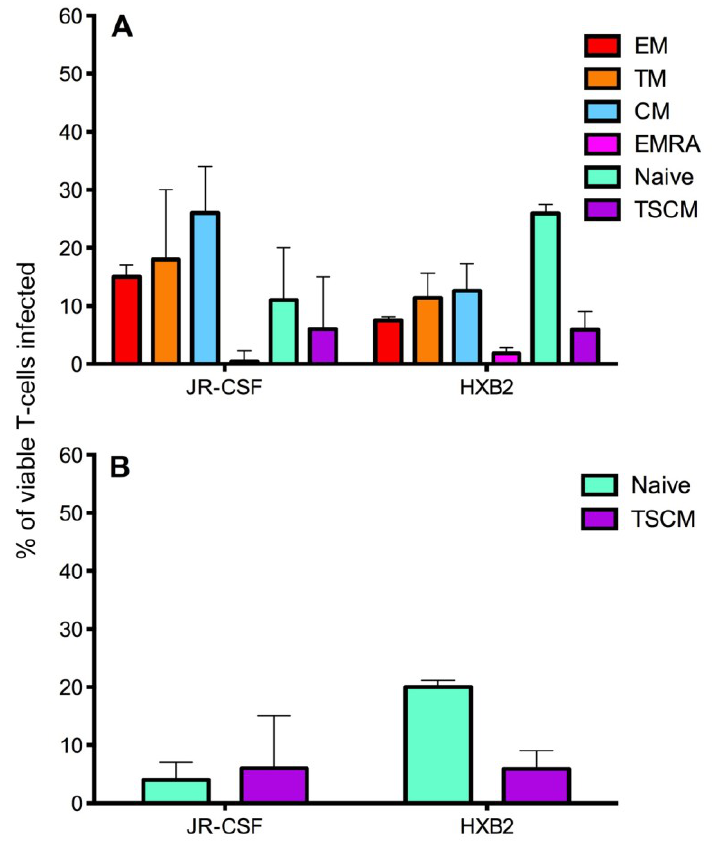
Figure 5. Infection of CD4 + T cell subsets by CCR5- and CXCR4-using viruses. CD4 + T cells were isolated from five donors and infected with JR-CSF (CCR5-using) or HXB2 (CXCR4-using) Env-pseudotyped GFP reporter viruses. Over 1 million events were collected on a LSR Fortessa flow cytometer 3 days post infection. ( A ) JR-CSF preferentially infected memory CD4 + T cells including CM, TM and EM. In contrast, HXB2 preferentially infected naïve T cells. Both viruses were able to infect TSCM. ( B ) Removal of JR-CSF infected TSCM (CD3 + CD4 + CD45RO − CD27 + CCR7 + CD122 + CD95 + ) from the infected naïve T cell gate (CD3 + CD4 + CD45RO − CD27 + CCR7 + , as TSCM share the markers CD45RO − CD27 + CCR7 + with naïve T cells) revealed a low level of infection of naïve T cells by JR-CSF, whereas HXB2 maintained a relatively high level of infection of naïve T cells. Percentages represent the percentage of naïve T cells infected by each virus, which are TSCM. Bar graphs represent the median and